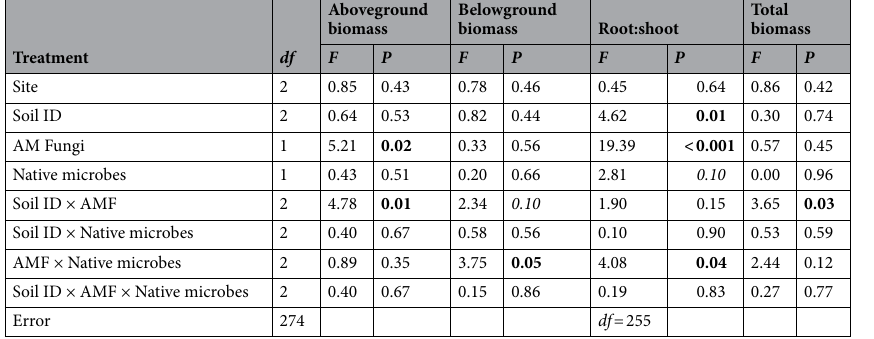
Table 1. Results from linear models testing the effects of the identity of native soil amendments (Soil ID), the presence of commercial AM fungi (AM Fungi), and the presence of native microbes on aboveground biomass, belowground biomass, root:shoot ratio, and total biomass of P. amarum . Bolded numbers are significant at P < 0.05. Italicized numbers are marginally significant at P < 0.10.